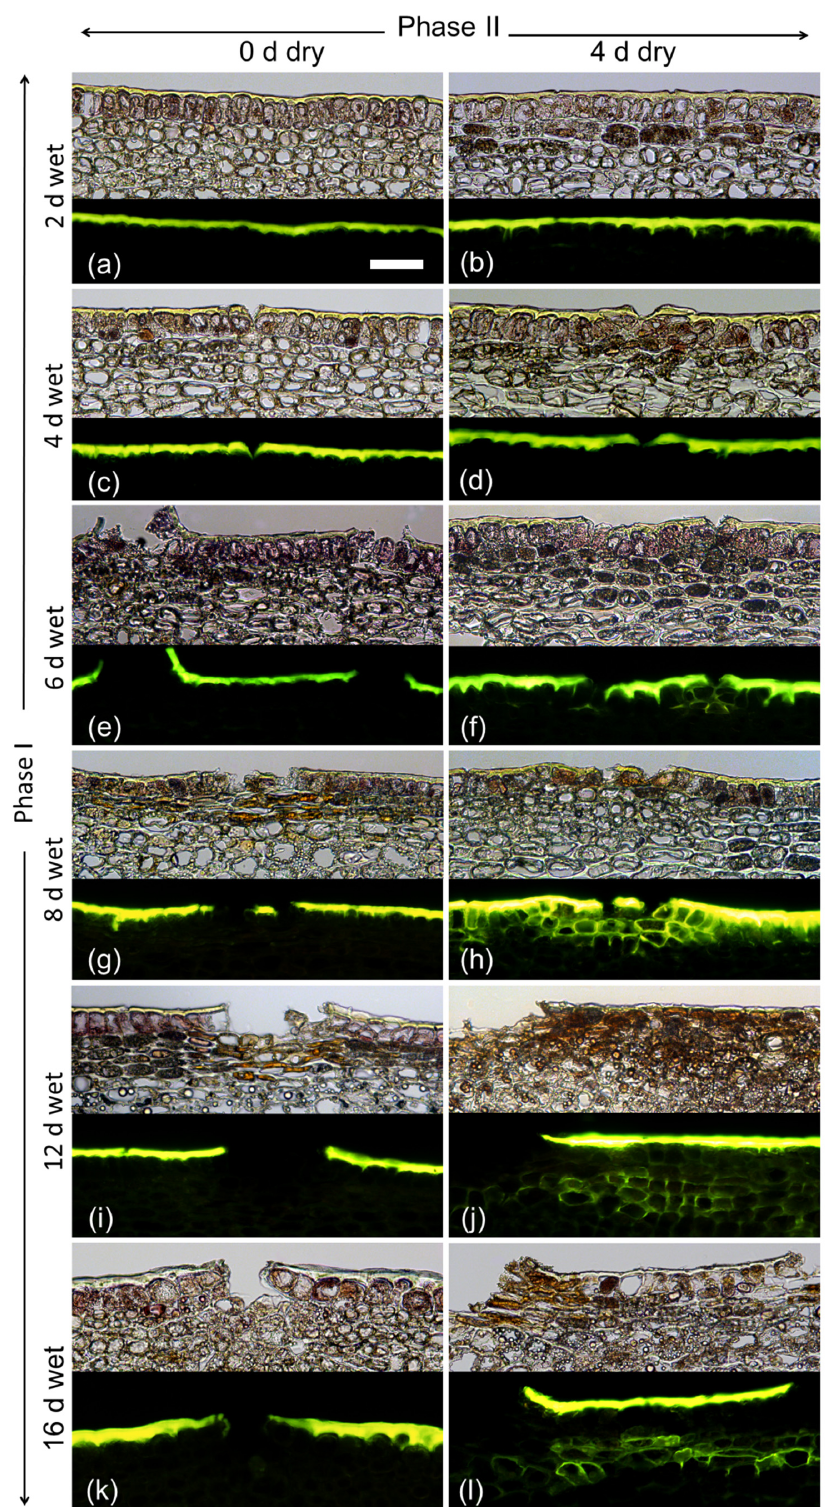
Figure 4. E ff ect of moisture exposure for 2 d ( a , b ), 4 d ( c , d ), 6 d ( e , f ), 8 d ( g , h ), 12 d ( i , j ) or 16 d ( k , l ) on periderm formation. The experiment comprised two phases: Phase I—time of moisture exposure and Phase II—time after termination of moisture exposure. Phase I was recorded immediately after termination of moisture exposure (0 d) ( a , c , e , g , i , k ). Phase II was recorded 4 d after termination of moisture exposure ( b , d , f , h , j , l ). Micrographs taken under transmitted white light (upper) or incident fluorescent light (lower) (filter module U-MWB) after being stained with Fluorol Yellow 088. The scale bar in ( a ) is 50 µ m long and representative of all images in the composite ( n =